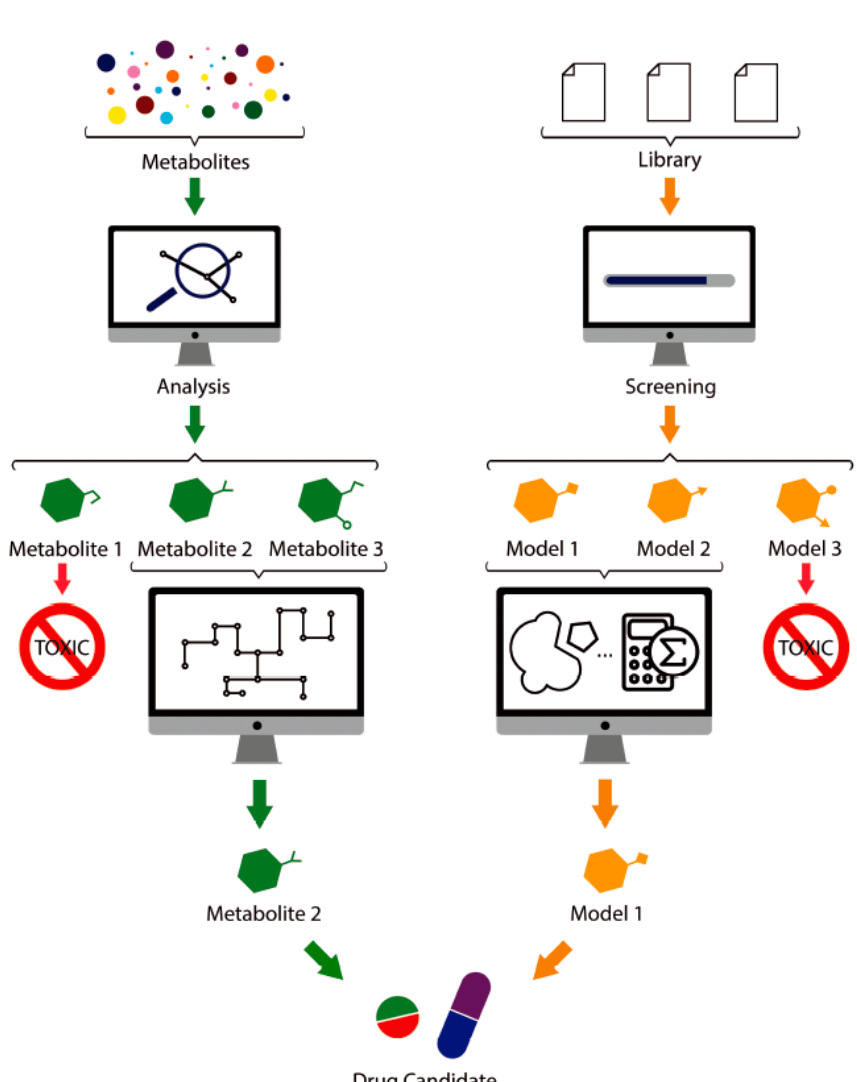
Figure 3. The use of metagenomics in the development of new drug candidates. The left